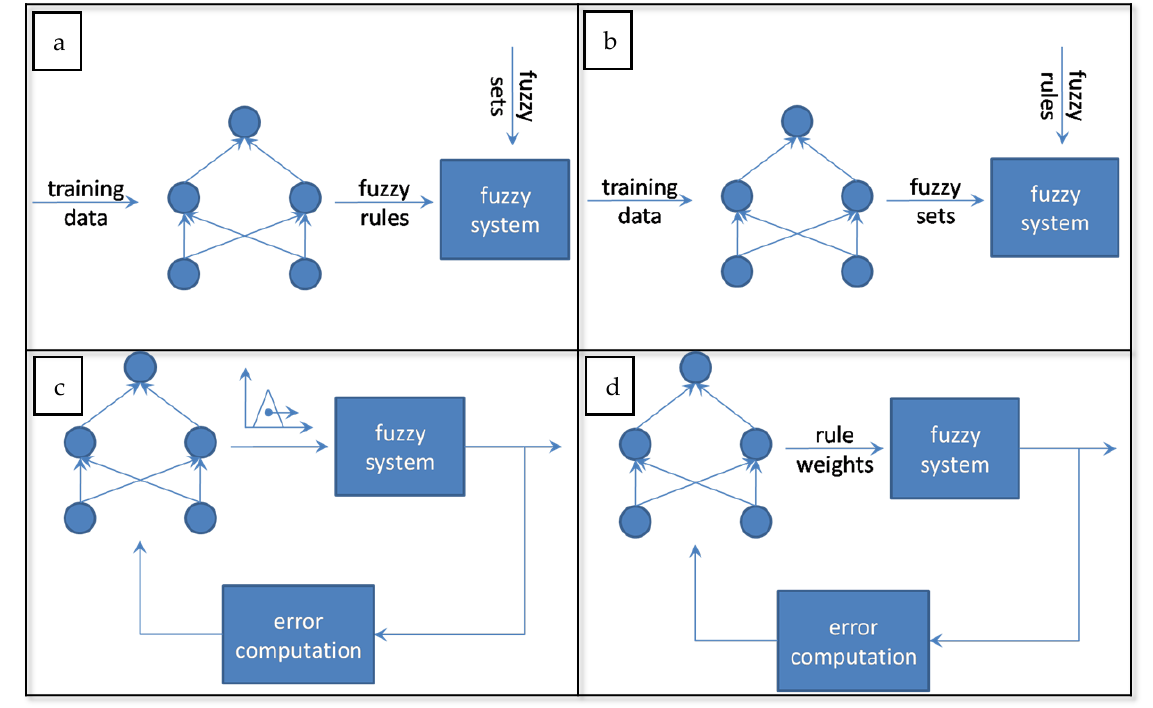
Figure 3. Cooperative neuro-fuzzy systems: ( a ) Type 1, ( b ) Type 2, ( c ) Type 3, and ( d ) Type 4.